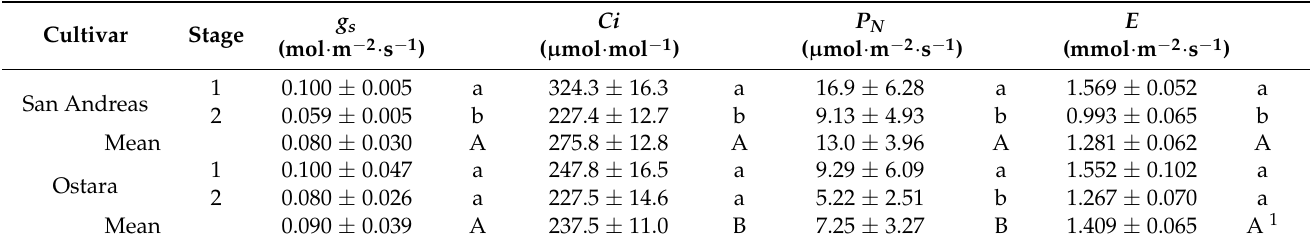
Table 3. Gas-exchange parameters at two growing stages (1—BBCH 61; 2—BBCH 85) of two strawberry cultivars.